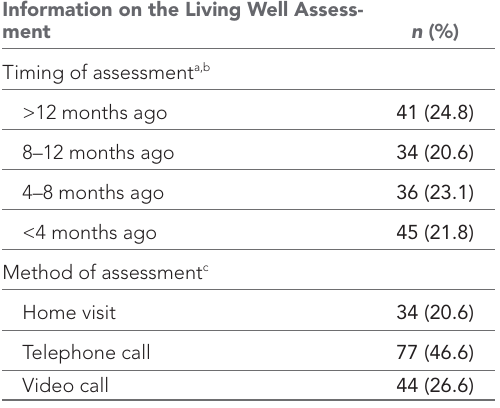
Table 2 Details of how and when the